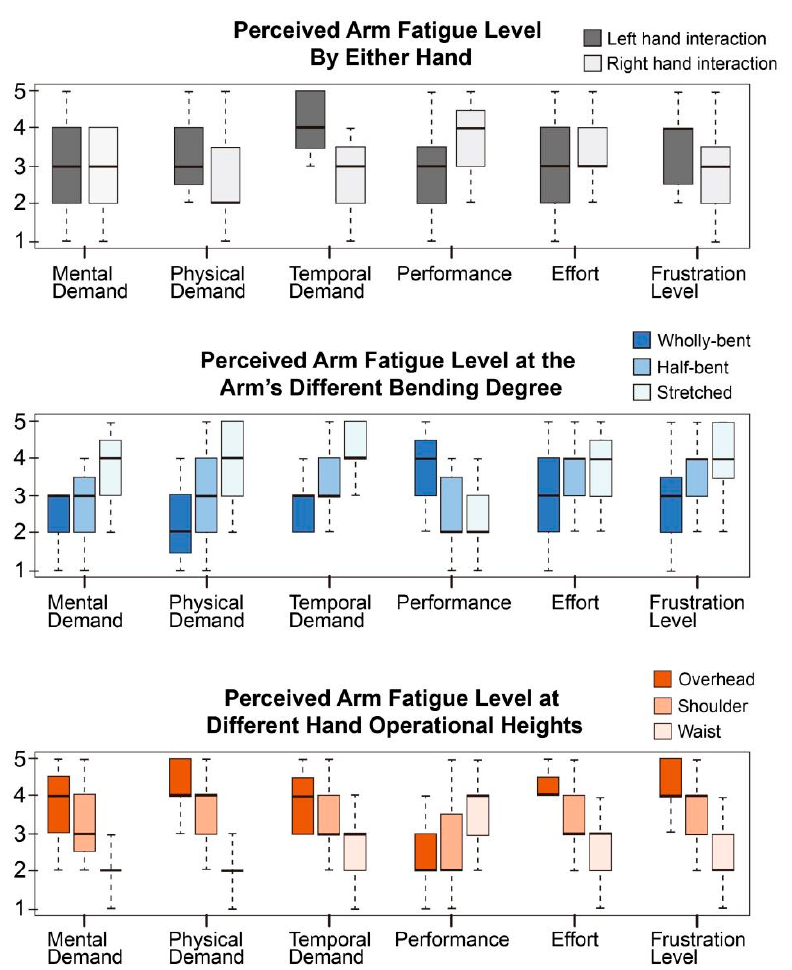
Figure 11. Perceived arm fatigue level in different conditions of hand choice, the arm’s bending degree and the hand-operational height.